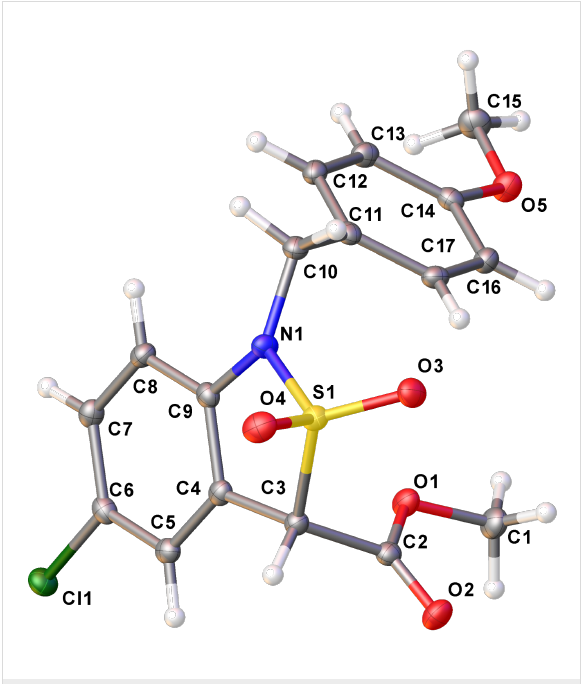
Figure 1: Structure of methyl 5-chloro-1-(4-methoxybenzyl)-1,3- dihydrobenzo[ c ]isothiazole-3-carboxylate-2,2-dioxide ( 10c ) in the crystal [CCDC: